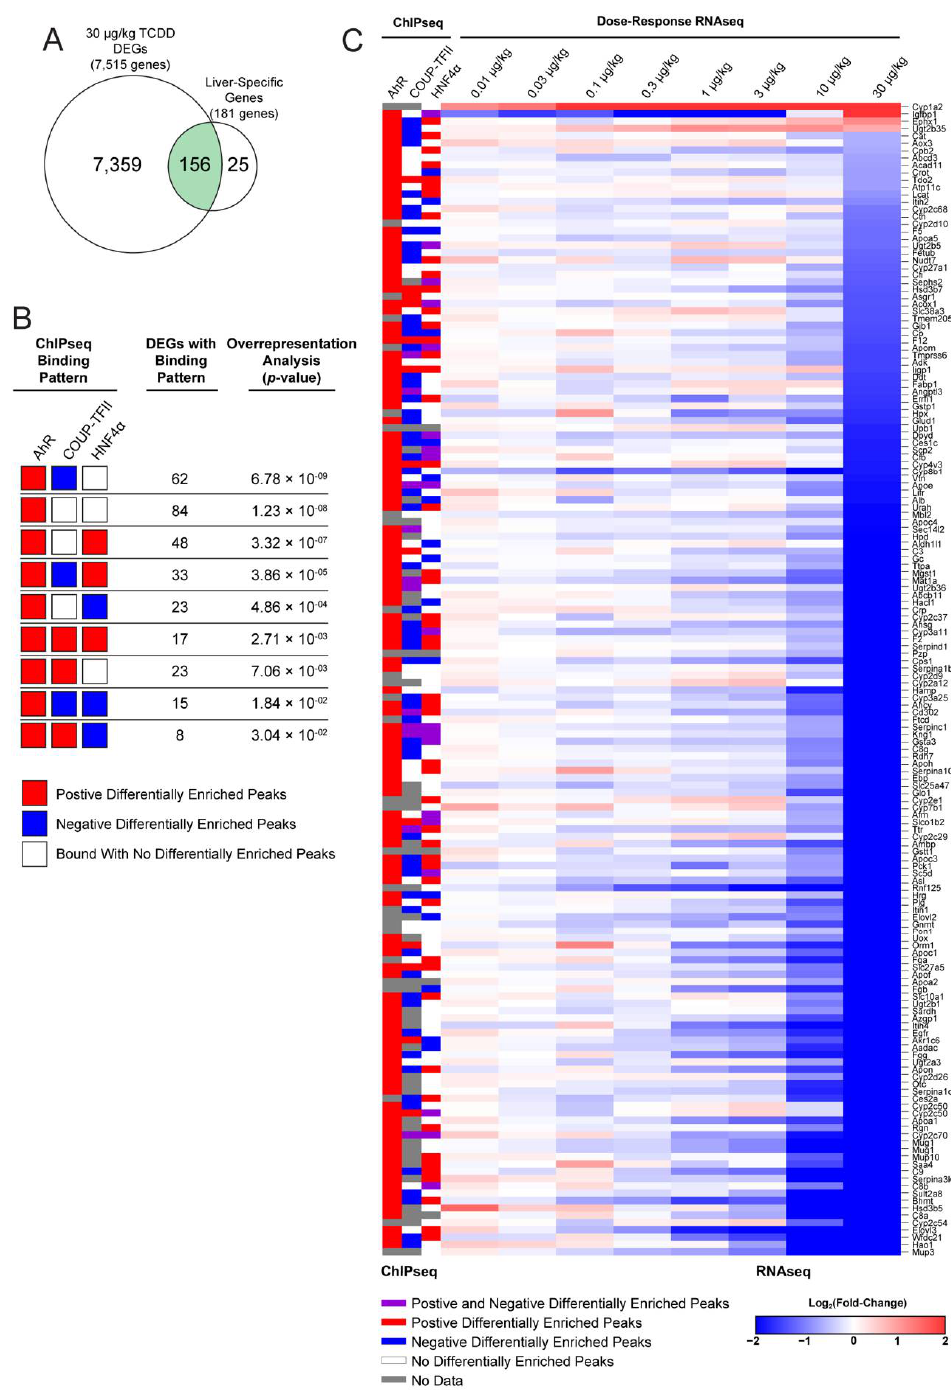
Figure 6. Integration of ChIPseq and dose response RNAseq for liver-specific DEGs. A total of 181 liver-specific genes were identified based on multi-tissue data from BioGPS as reported in Nault et al. [18]. ( A ) Differential gene expression was assessed for liver-specific genes in mice treated with 30 µg/kg TCDD every 4 days for 28 days. ( B ) Over-representation analysis of select transcription factor binding patterns for the 156 liver-specific DEGs was assessed using a one-sided Fisher’s exact test with FDR correction. Over-representation analysis of all transcription factor binding patterns is available in Supplementary File S3. ( C ) AhR, COUP-TFII, and HNF4 α binding was mapped to expression of 103 liver-specific DEGs at all doses (0.01–30 µ g/kg). Genes are ranked from most induced to most repressed at 30 µ